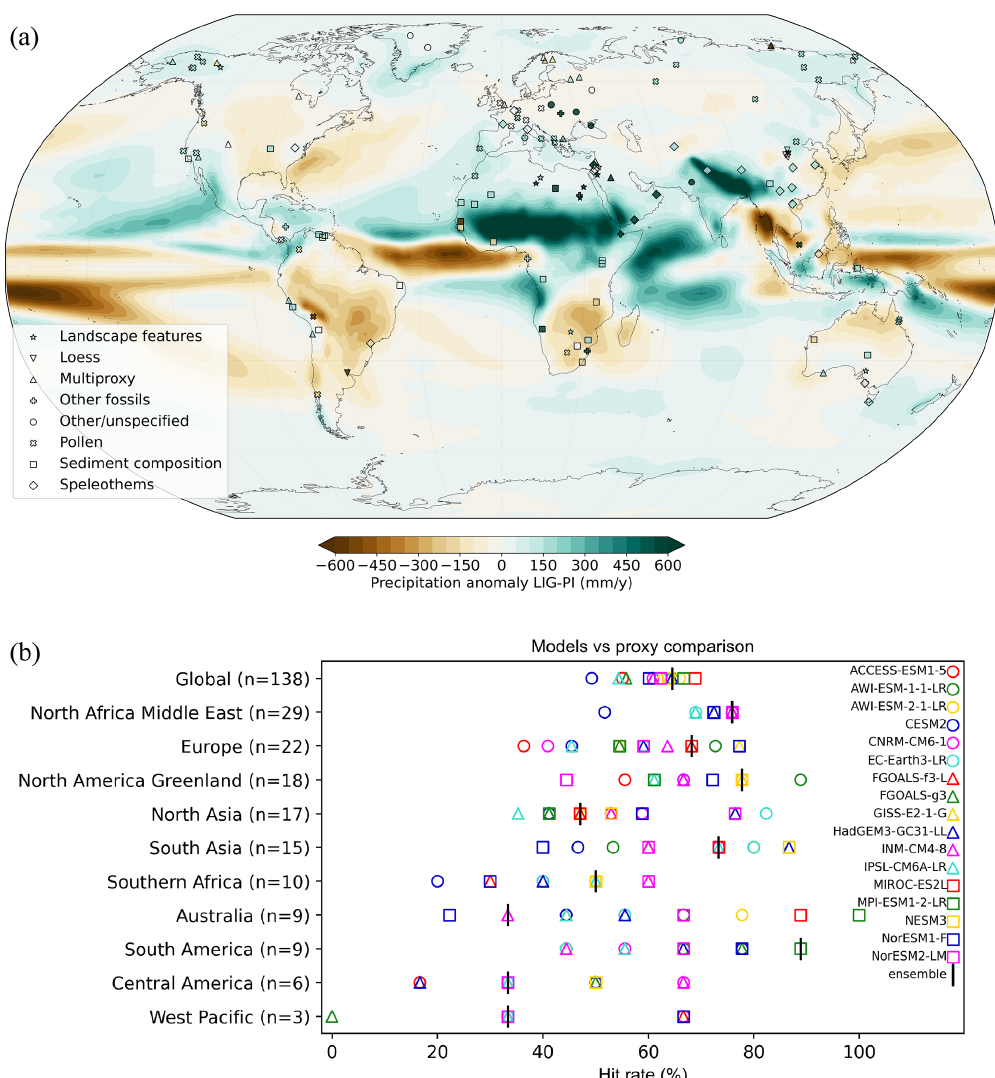
Figure 13. (a) Annual precipitation anomaly between 127ka and PI, from model simulations (ensemble average in contoured colors) and from proxies (filled markers). Green colors indicate higher precipitation at 127ka from models or proxies, and the opposite is true for brown colors. Proxy anomalies are on a semi-quantitative scale: dark green (much wetter LIG), light green (wetter), white (no noticeable anomaly), light brown (drier), and dark brown (much drier). Different markers represent different types of proxy records as specified in the legend. Proxy reconstruction from Scussolini et al. (2019). (b ) Annual precipitation anomaly between LIG and PI; comparison of models and proxies. The hit rate is the percentage of matches between the sign of the anomaly in the models and in the proxies. N is the number of model–proxy comparisons per